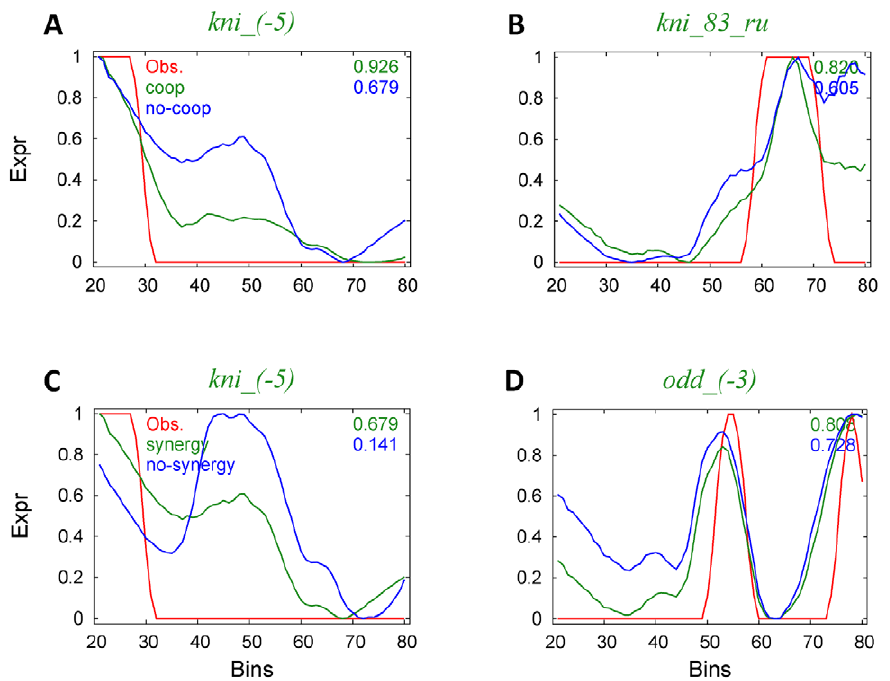
Figure 2. Effect of cooperative DNA-binding of TFs and the mode of transcriptional activation (multiplicative or not) on model performance. (A,B) Predicted expression profiles of a DirectInt model with no cooperativity (‘‘no-coop’’, blue) and a model with self-cooperative binding for Bcd and Kni (‘‘coop’’, green) are shown for each CRM, with reference to the CRM’s known readout (‘‘Obs.’’, red). The correlation coefficient between a model’s prediction and the known readout is indicated in the top right corner of the panel. Each expression profile is on a scale of 0 to 1 (scaling does not affect correlation coefficient), and shown for bins 20 to 80 (i.e., 20% to 80% egg length) of the embryo. Shown are two CRMs for which one model was deemed better than the other (CC $ 0.65, difference in CC $ 0.05). (C,D) Predicted expression profiles of a DirectInt model with multiplicative activation (‘‘synergy’’, green) and one with additive activation (‘‘no-synergy’’, blue). Shown are two CRMs where the multiplicative model is better than the additive model (CC $ 0.65, difference in CC $ 0.05). Self-cooperative DNA-binding was not used in this